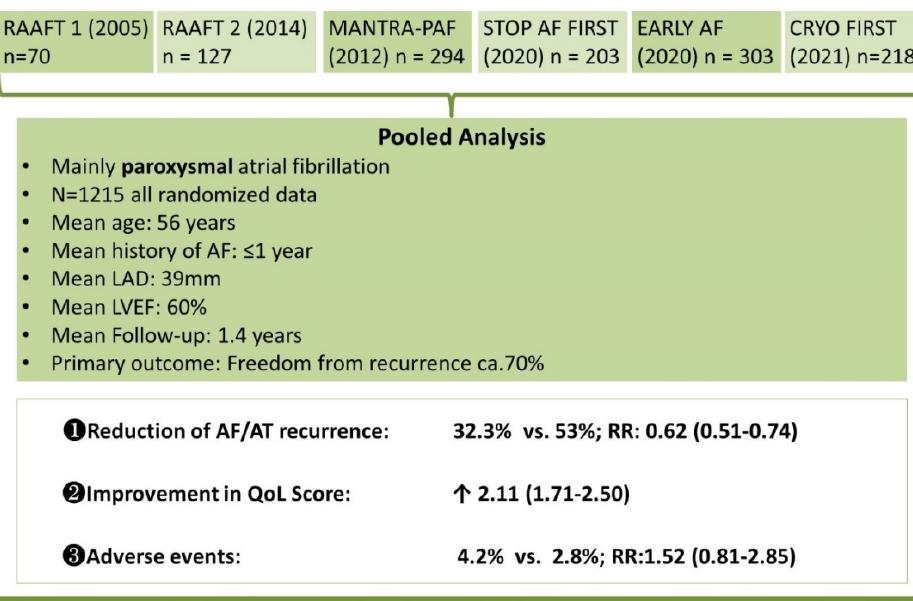
Figure 2. Catheter Ablation as Early Initial Therapy for Paroxysmal Atrial Fibrillation.